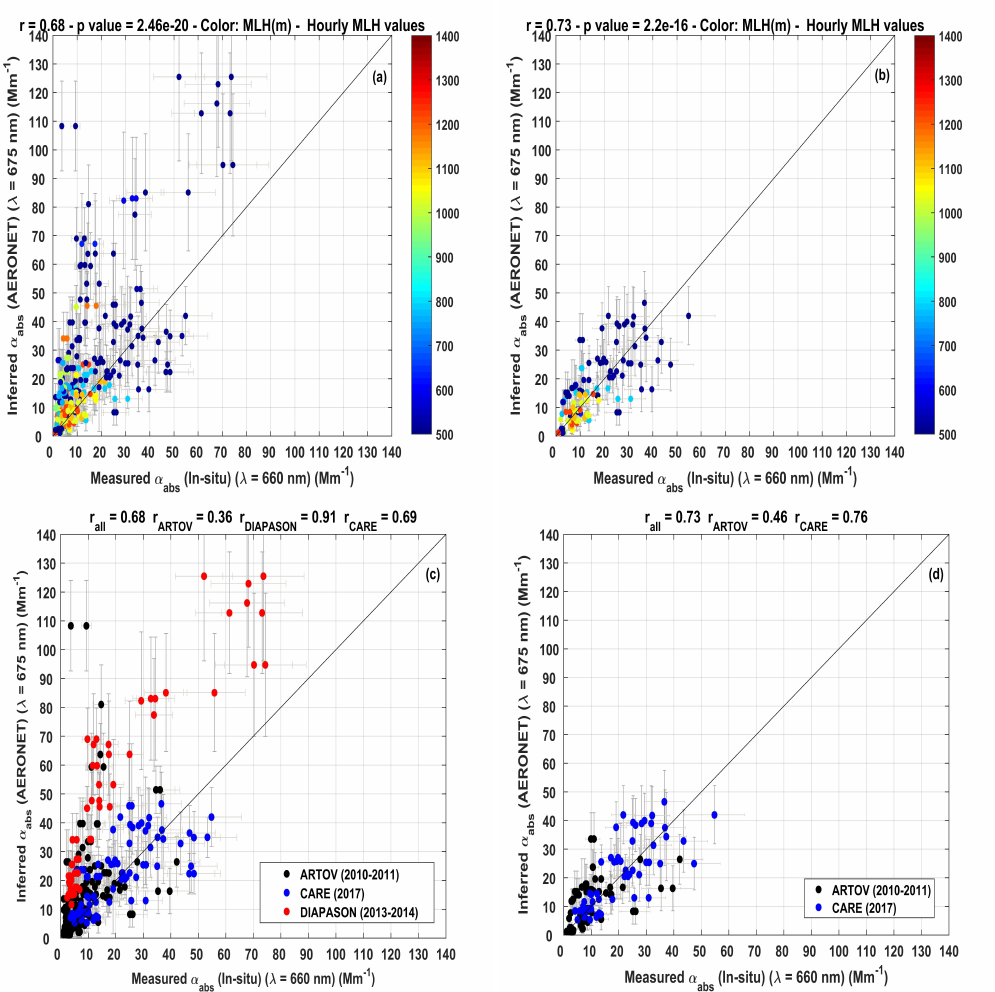
Figure 3. Comparison of the aerosol light absorption coefficients ( α abs ) inferred from AERONET with surface α abs . Panels show scatter plots of: ( x -axis) surface α abs obtained from in-situ measurements, ( y -axis) α abs obtained from AERONET data, before ( a , c ), and after ( b , d ) applying the screening scheme. The color code shows the hourly mixing layer height in panels ( a , b ), and the aerosol type dominating the field measurements (urban pollution during CARE 2017 [15], dust during DIAPASON 2013–2014 [10], mixed during ARTOV 2010–2011 [12]) in ( c , d ). Black line is the 1-to-1 line. ± 15 min average values of α abs are used. Data measured from November 2010 to February 2017 are shown. Thin grey lines indicate the measurement error associated with the α abs